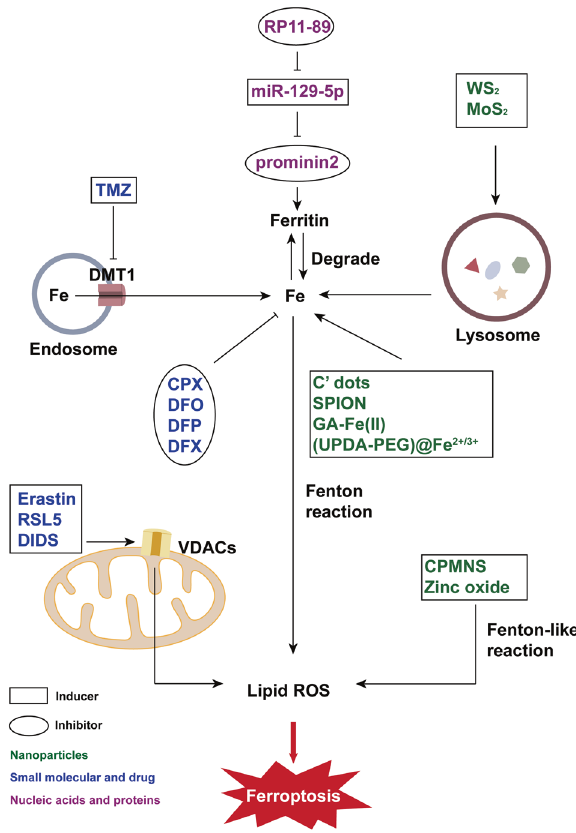
Fig. 1 Ferroptosis regulators associated with iron metabolism. Ferroptosis depends on iron ion because it can produce lipid ROS through Fenton reaction. Therefore, substances that regulate iron ions, such as iron chelators and regulators of related proteins or organelles, also function in the regulation of ferroptosis. Addition- ally, many nanoparticles based on other metal ions are also able to induce ferroptosis by effecting iron ions or directly generating ROS. TMZ temozolomide, DMT1 divalent metal transporter 1, Fe ferrum (iron), CPX ciclopirox olamine, DFO deferoxamine, DFP deferiprone, DFX deferasirox, RSL5 RAS synthetic lethal 5, DIDS 4,4 ′ -diisothiocya- nostilbene-2,2 ′ -disulfonic acid, VDACs voltage-dependent anion channels, C ’ dots Cornell prime dots, SPION superparamagnetic iron oxide nanoparticles, CPMNS hybrid CoMoO4-phosphomolybdic acid nanosheets, ROS reactive oxygen species.